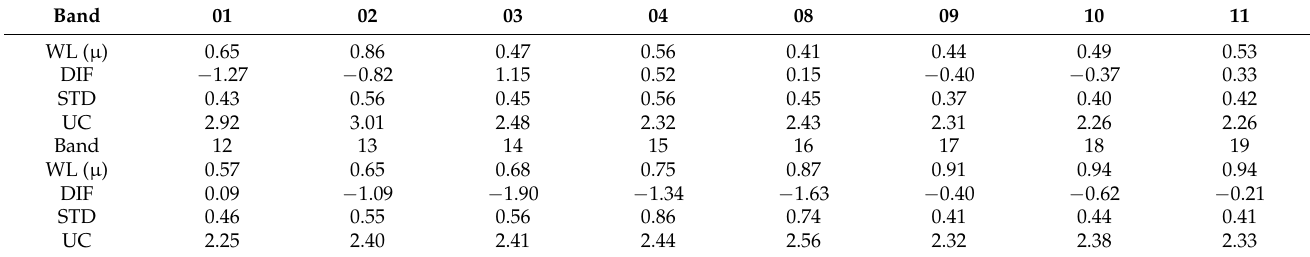
Table 4. Lunar calibration inter-comparison results for SNPP and N20 VIIRS (WL: